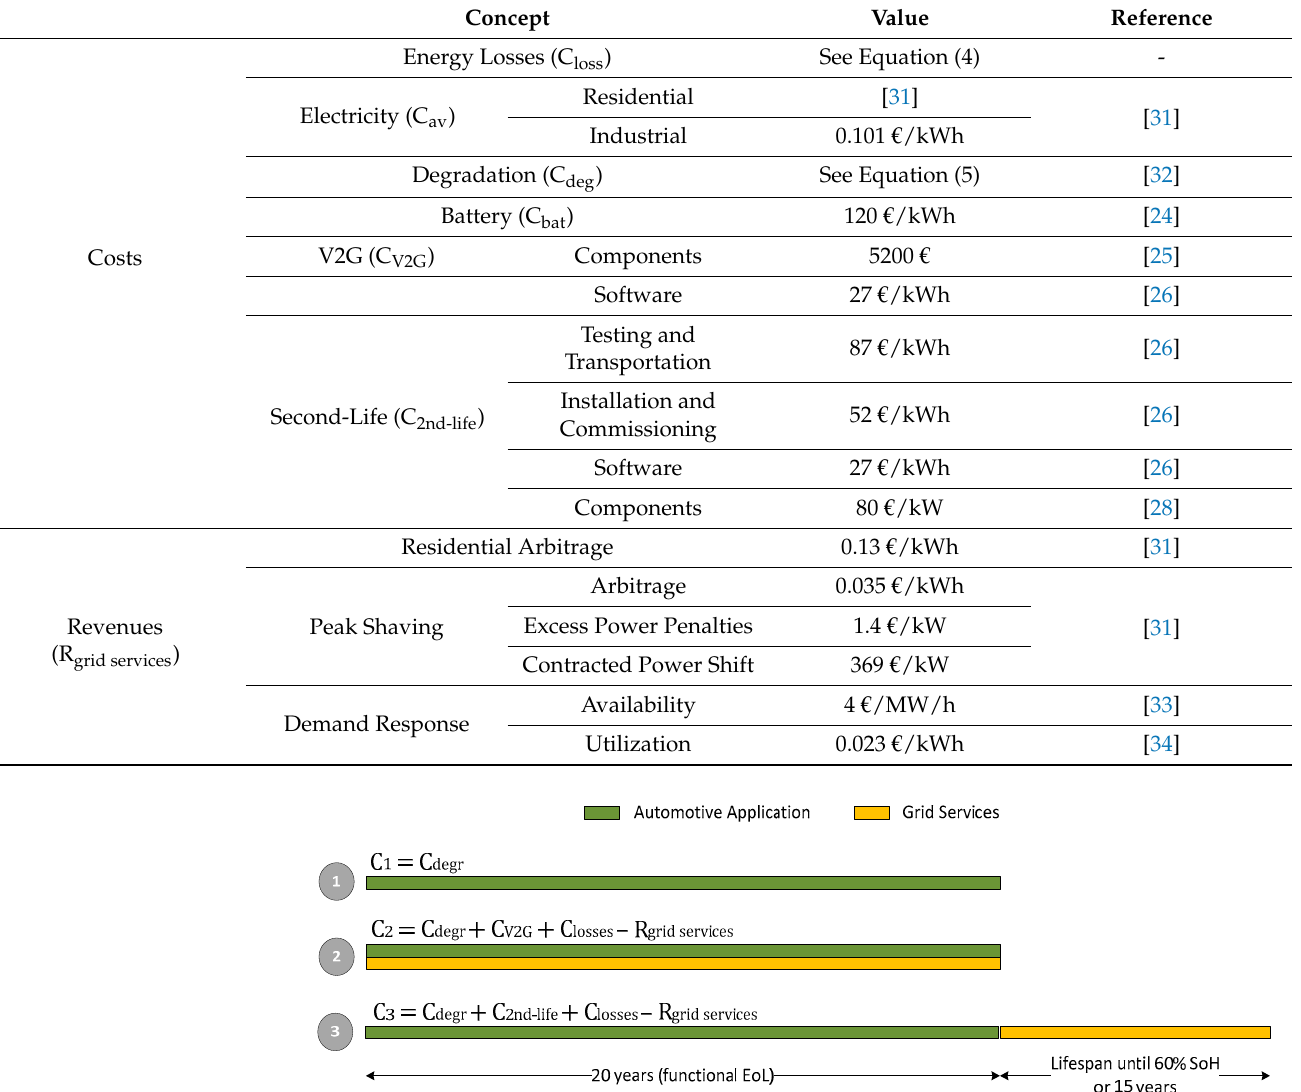
Table 4. Costs and revenues considered.